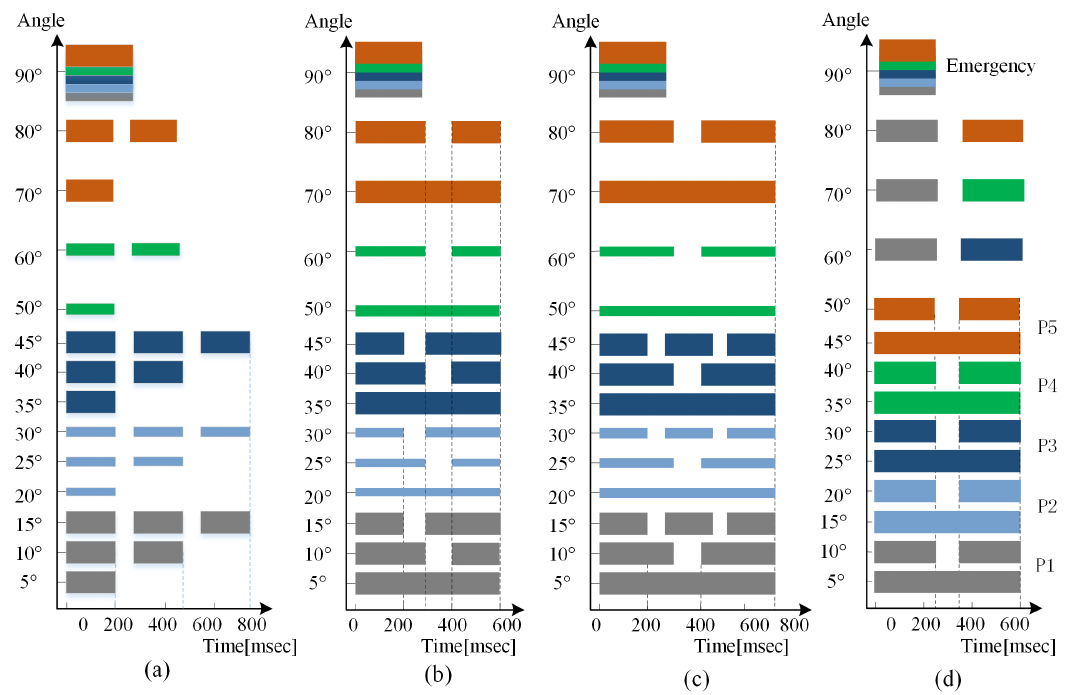
Figure 8. Schematic diagram of coding methods with combination of three parameters: ( a ) location, rhythm of times and intensity (LRI1); ( b ) location, rhythm of duration and intensity (LRI2); ( c ) location, rhythm of times and intensity (LRI3); ( d ) location, rhythm and mode (LRM). For the convenience of labelling angel intervals, five degrees in vertical coordinate indicates the interval [5, 10) in Table 3, 10 indicates [10, 15) and so forth.